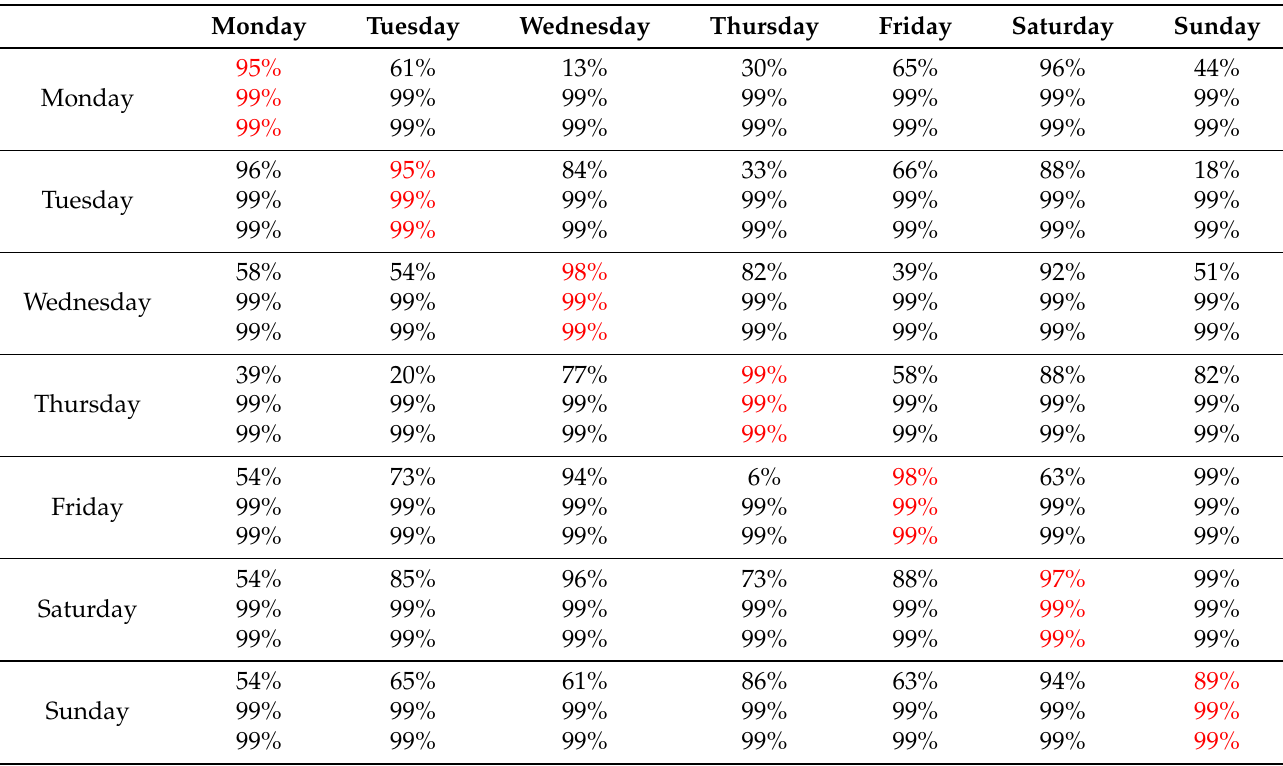
Table 5. Dynamic FPCA test between temperature and electricity demand.We highligth the diagonal in